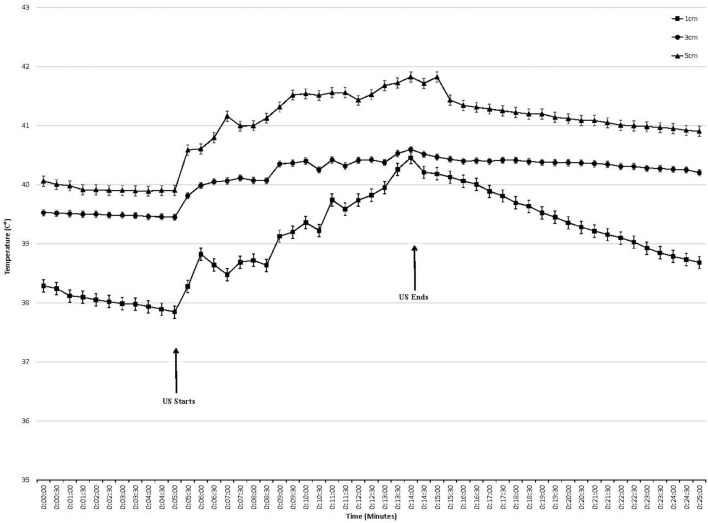
Tissue temperature change in epaxial muscles during therapeutic ultrasound 2.0 W/cm2. Ultrasound starts at 5 min and ends at 15 min. Values presented as mean ± SEM.